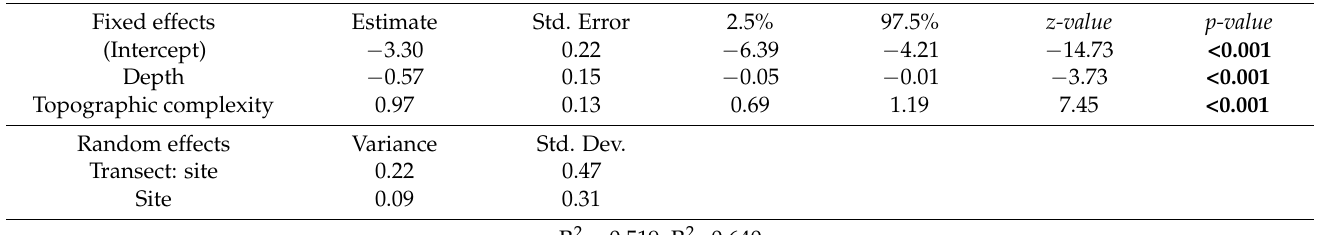
Table 2. Summary of the final GLMM fits modelling fish abundance and fish richness. Depth, topographic complexity, and sampled area are standardised explanatory variables. Transect (N = 18) and site (N = 4) are nested random effects in both models. Std. Error: standard error, Std. Dev.: standard deviation, R 2 m: marginal pseudo-r-squared, R 2 c: conditional pseudo-r-squared. N = 120. p -values < 0.05 highlighted in bold. Fish Abundance Negative Binomial Distribution ( thetha =